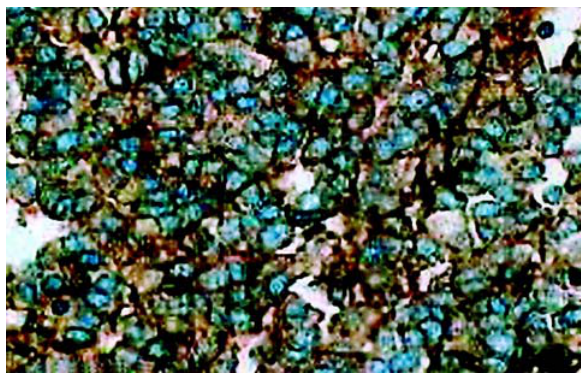
Figure 3 – CD99 positivity (Immunohistochemical staining,